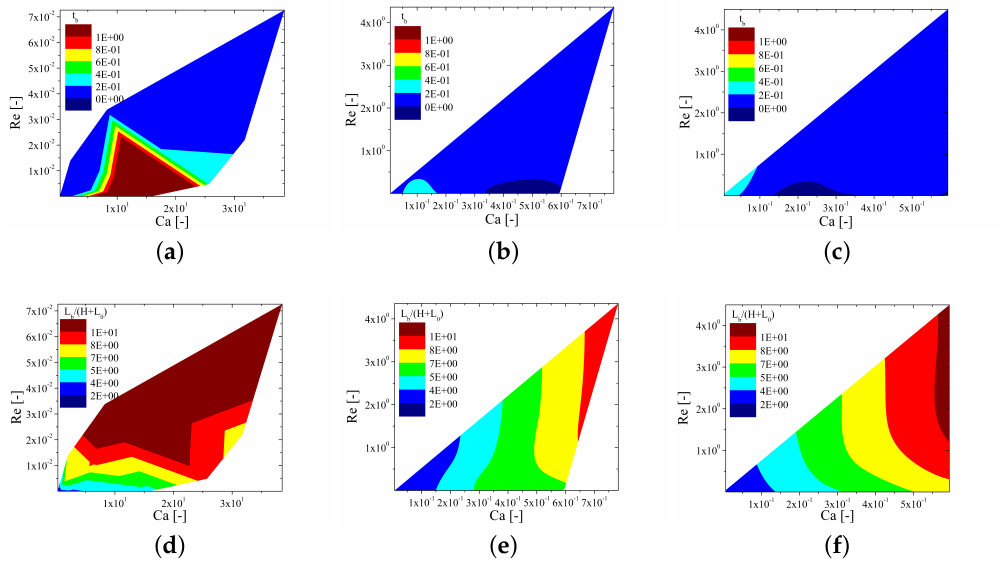
Figure 12. Contour plots of the breakup time (top row) and normalized breakup height (bottom row) as a function of the capillary and Reynolds numbers for the three different inks considered: HexaS ( a , d ), Hexa1 ( b , e ), and Newtonian ( c , f